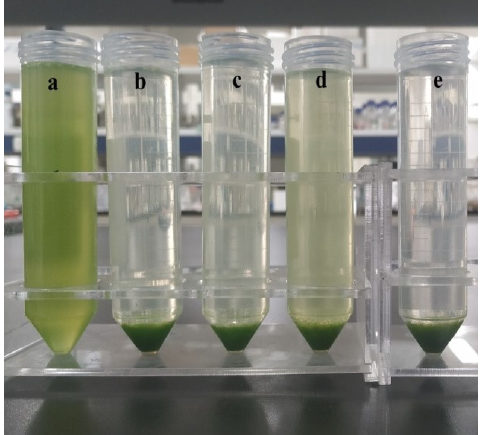
Figure 1. Flocculation formed by different flocculants (a: raw; b: Al 2 (SO 4 ) 3 ; c: AlCl 3 ; d: Fe 2 (SO 4 ) 3 ; e: FeCl 3 ).